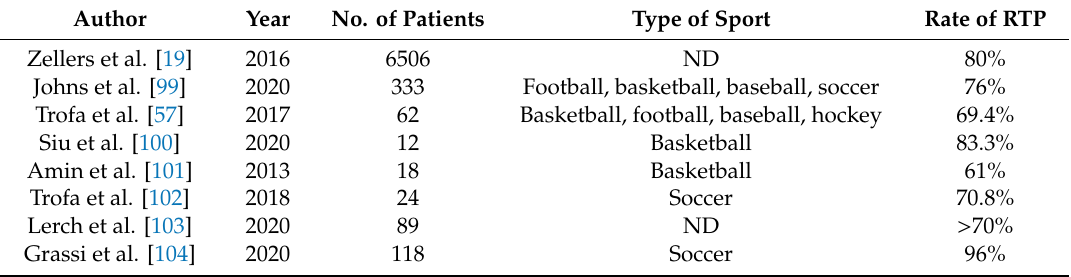
Table 2. Rate of